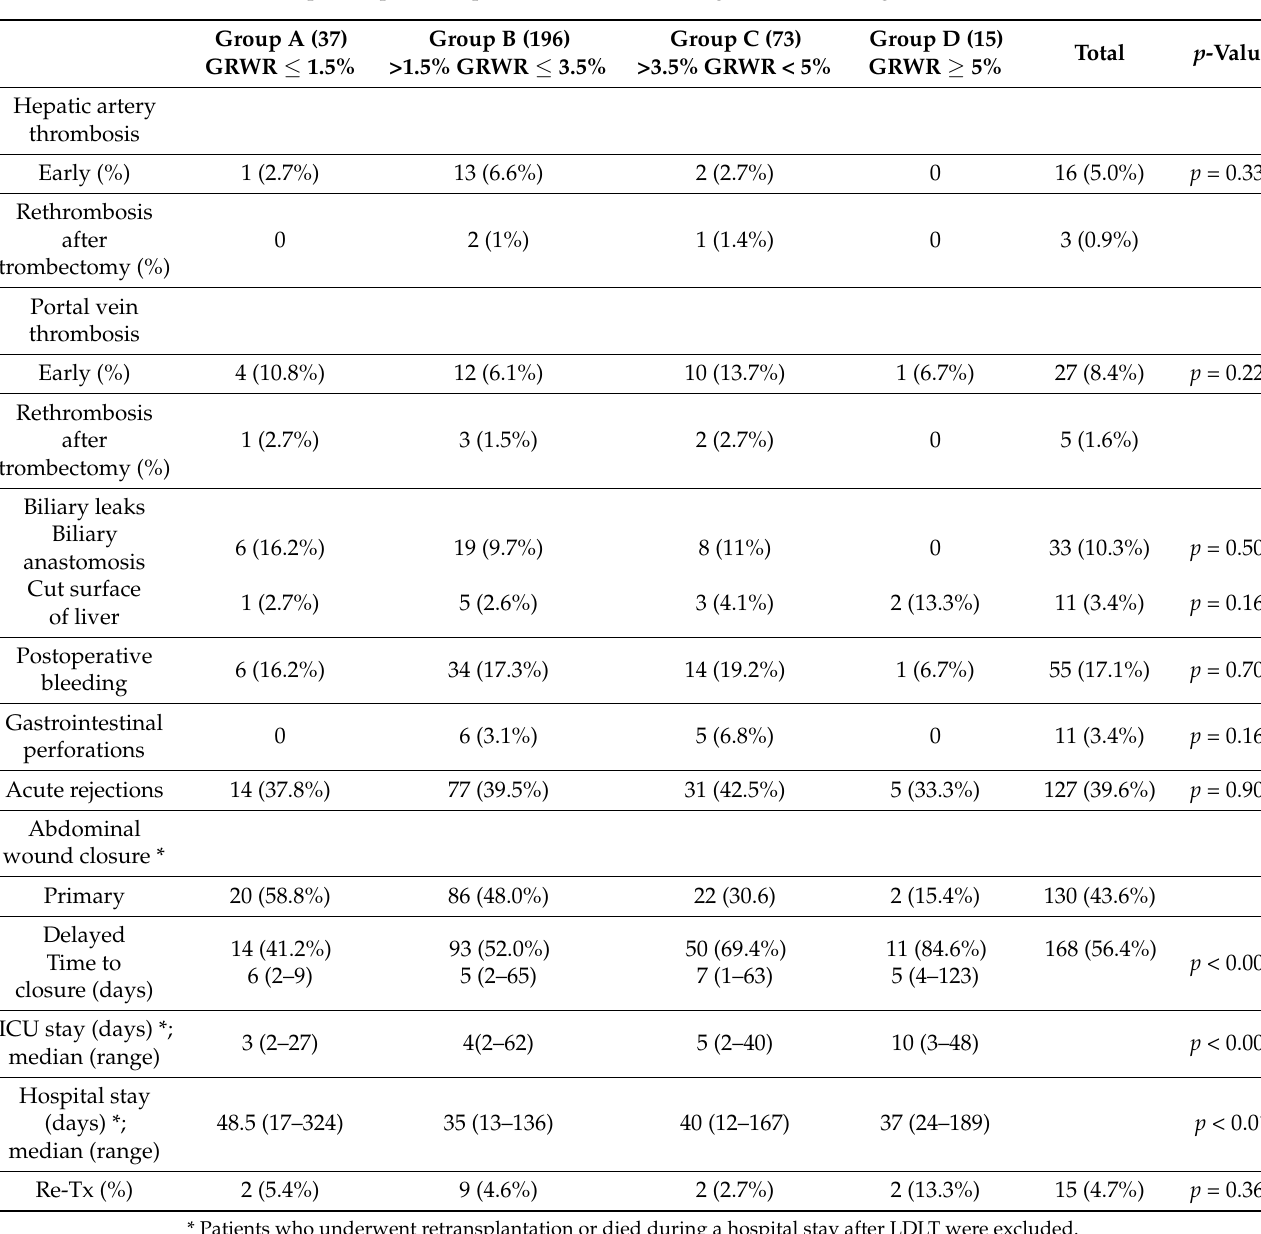
Table 5. Recipients’ posttransplant outcomes following LDLT according to the GRWR